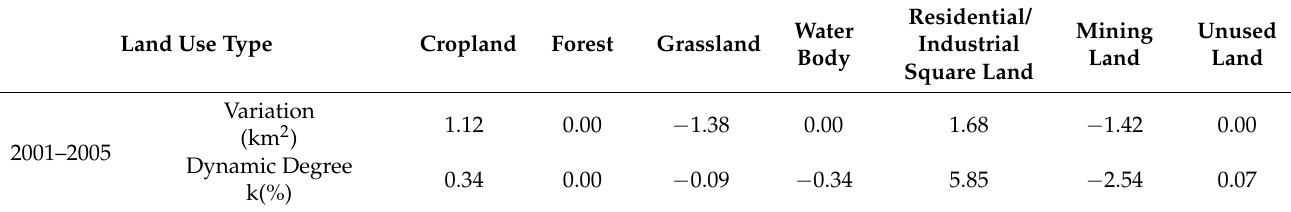
Table 2. Dynamic degree of land use in open-pit coal mines (2001 – 2020).